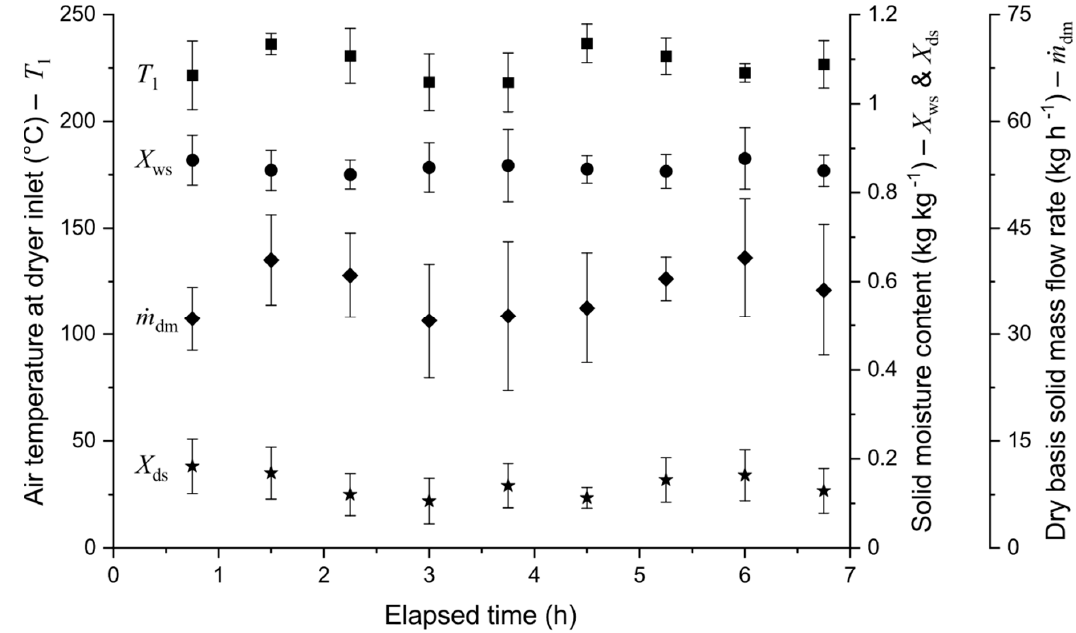
Figure 6. Air temperature at the dryer inlet ( ▪ ), wet solid moisture content ( ● ), dried solid moisture content ( ★ ), dry basis solid mass flow rate ( ◆ ) at a pneumatic dryer used for cassava processing in Ghana (error bars shows standard deviation).